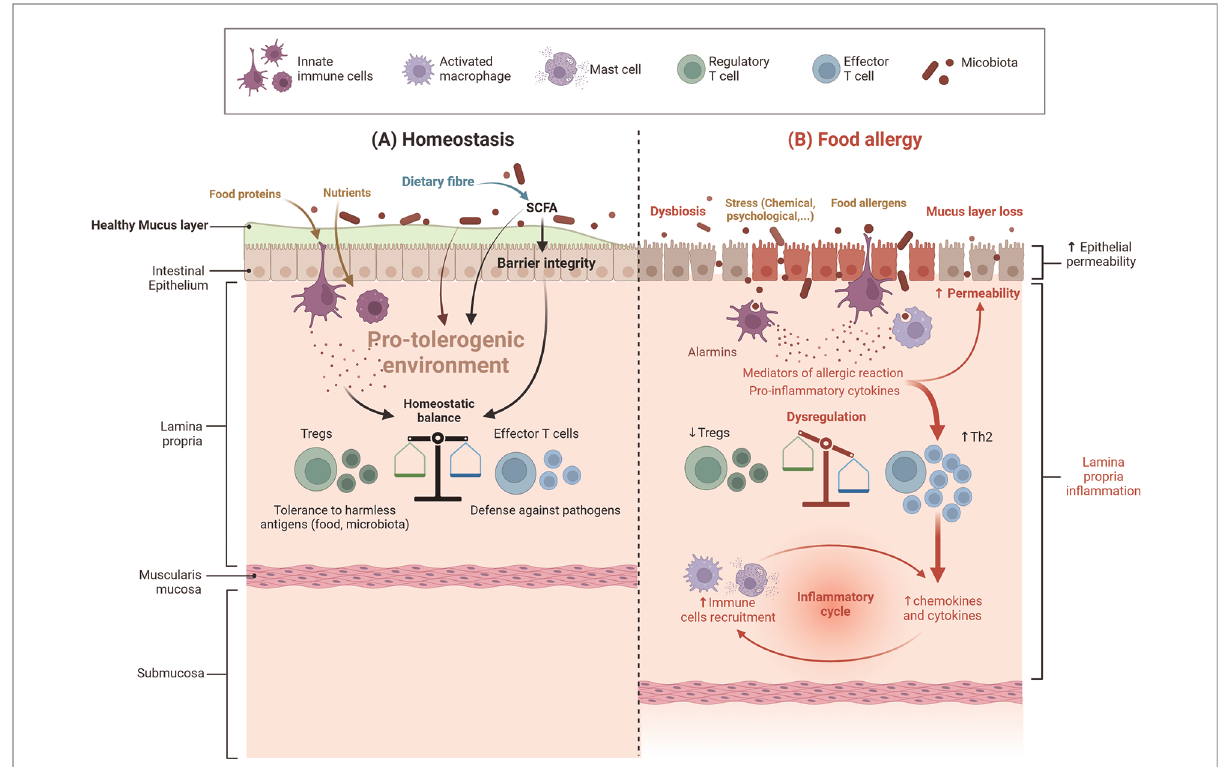
FIGURE 1 Intestinal barrier in a steady vs. food allergy state. ( A ) Under homeostatic conditions (cohesive intestinal barrier, diverse and active microbiota, exposure to food antigens), antigen-presenting cells promote the induction of food antigen-speci fi c Treg cells. These cells induce tolerance to dietary antigens by a range of mechanisms, including inhibition of antigen-speci fi c T helper type 2 (Th2) cell responses, suppression of pathogenic Th2 cell-like reprogramming of T cells and of mast cell activation, and the production of barrier-protective cytokines; SCFA: short- chain fatty acids ( B ) In food allergy, dysbiosis associated with an impaired gut barrier compromise the differentiation of naive T cells into Treg cells and instead leads to the differentiation of type 2 adaptive T helper cells (Th2) and in fl ammation – more details are provided in the text and in Figure 2 (Created with